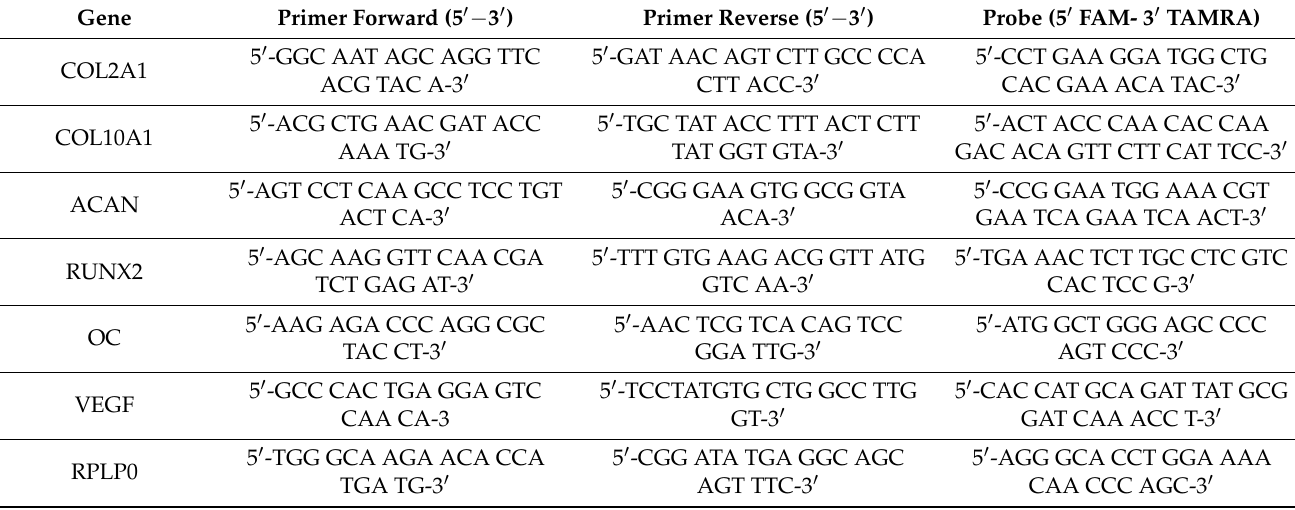
Table 1. Human oligonucleotide primers and probes used for